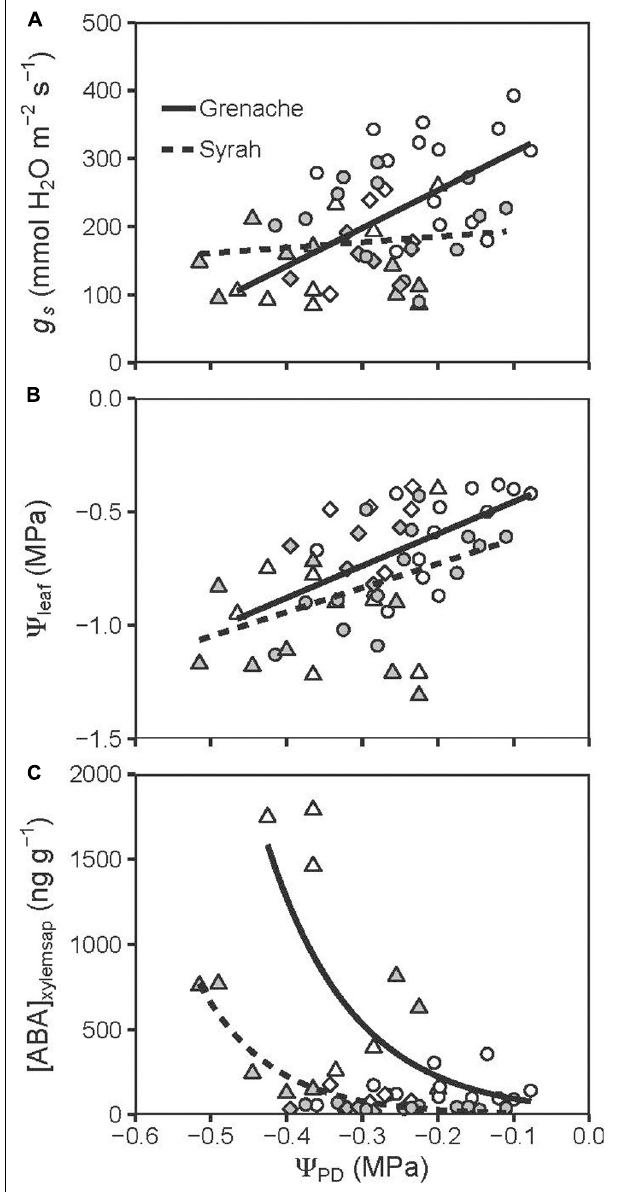
FIGURE 2 | Correlation between (cid:57) PD and g s (A) , (cid:57) leaf (B) , and [ABA] xylemsap (C) for well-watered (circles), water deficit (triangles), and recovery from water stress vines (diamonds) from the cultivars Grenache (open symbols) and Syrah (filled symbols). (A) Grenache and Syrah show a significantly different ( P = 0.017) relationship between (cid:57) PD and g s : in Grenache g s is significantly positively correlated to (cid:57) PD ( r = 0.58, P = 0.002) while no correlation was found for Syrah ( r = 0.14, P = 0.487). (B) For both cultivars (cid:57) leaf is significantly positively correlated to (cid:57) PD [Grenache: r = 0.54, P = 0.004; Syrah: r = 0.44, P = 0.021]. No significant differences were found for the slope ( P = 0.580) and intercept ( P = 0.091) of the linear regression lines [Grenache: (cid:57) leaf (MPa) = 1.4 ± 0.4 × (cid:57) PD (MPa) –0.3 ± 0.1; Syrah: (cid:57) leaf (MPa) = 1.1 ± 0.4 × (cid:57) PD (MPa) –0.5 ± 0.1]. (C) Non-linear regressions between (cid:57) PD and [ABA] xylemsap for Grenache ([ABA] xylemsap = 39.1 ± 60.4 ng g − 1 × exp[–8.7 × ± 4.3 (1/MPa) × (cid:57) PD (MPa)]) and Syrah ([ABA] xylemsap = 3.3 ± 5.7 ng g − 1 × exp[–10.5 × ± 3.5 (1/MPa) × (cid:57) PD (MPa)]).